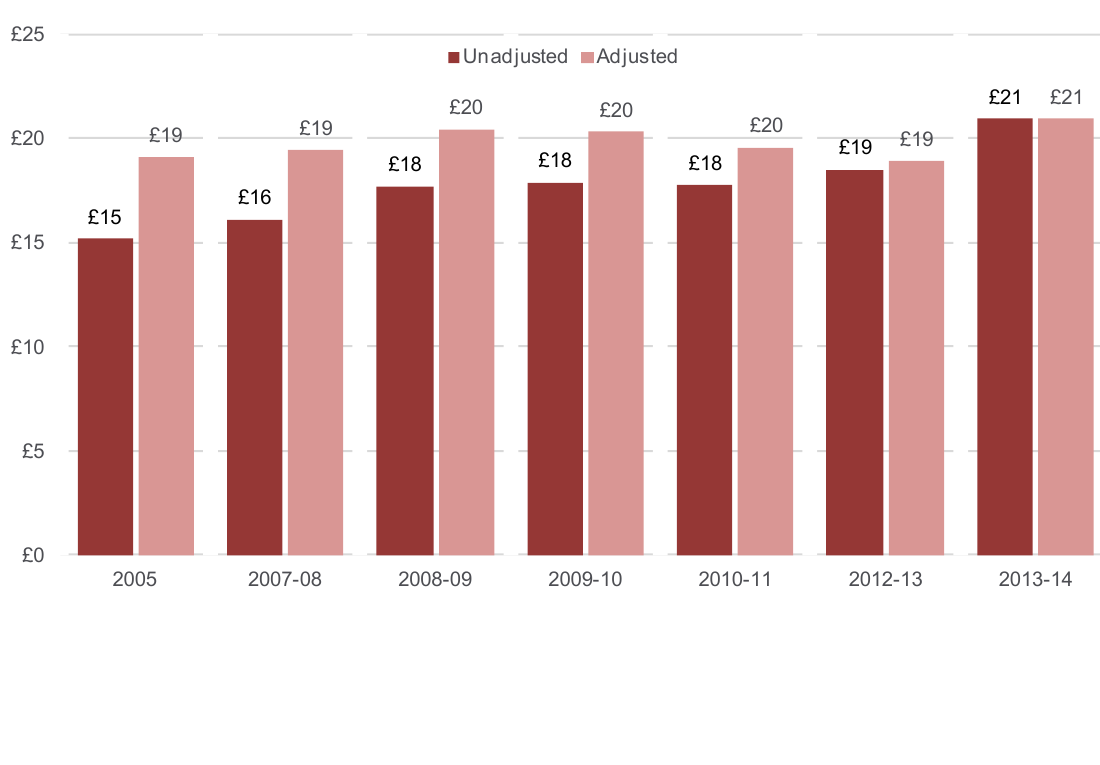
Figure 6: Average amount given to charity in the four weeks prior to interview, adjusted for inflation and unadjusted, 2005 to